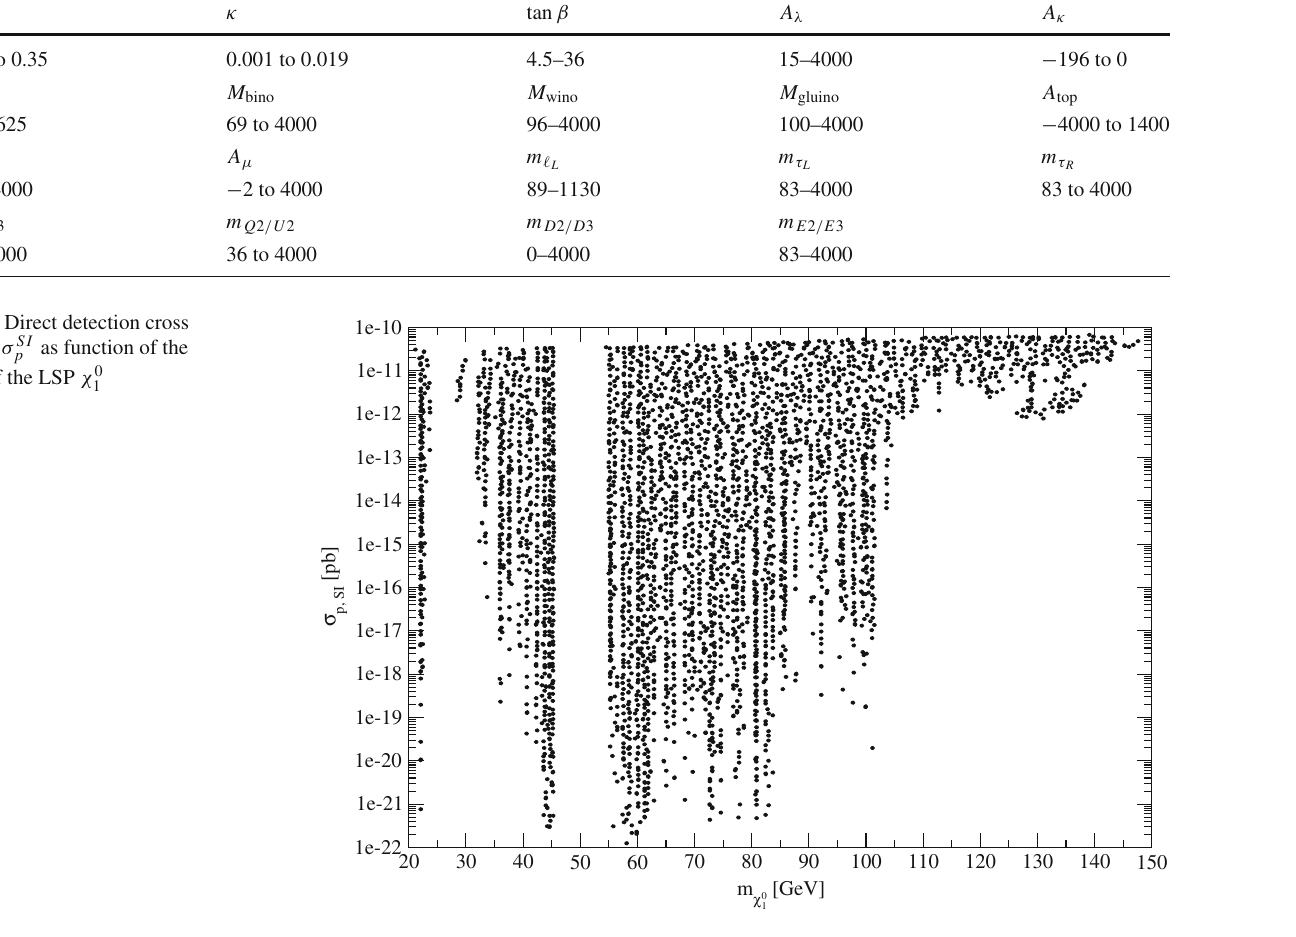
Table 1 The ranges of the NMSSM specific couplings, soft SUSY breaking terms and masses (soft SUSY breaking terms and masses in GeV) leading to points satisfying all constraints